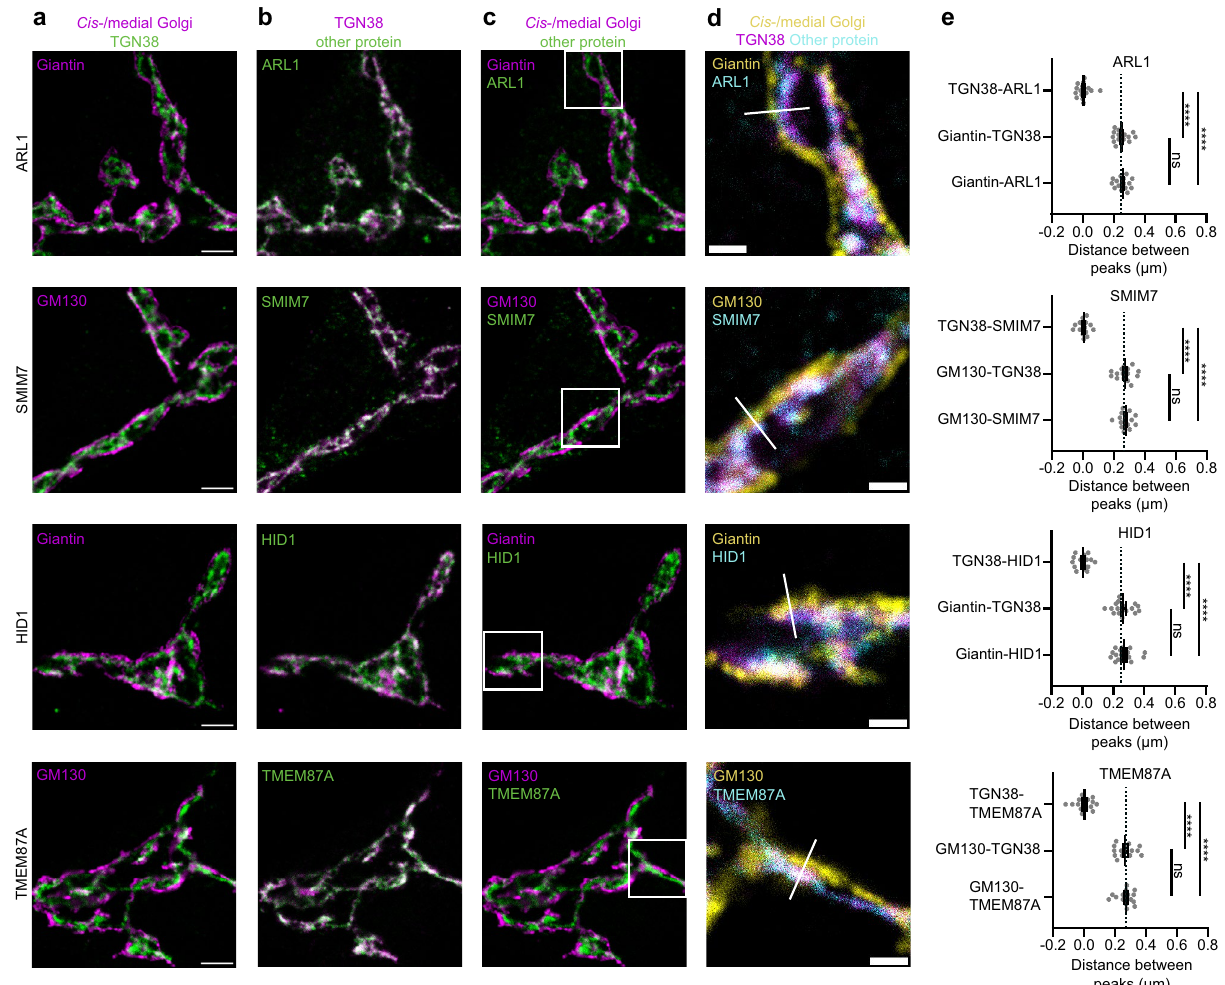
Figure 3. Several Golgi proteins overlap with TGN38. ( a – c ) Representative examples of neurons immunostained for a cis -/medial Golgi marker (GM130 or giantin), TGN38 and a protein of interest (ARL1, SMIM7, HID1 and TMEM87A). Images showing immunostaining of cis -/medial Golgi marker and TGN ( a ), TGN and protein of interest ( b ), cis -/medial Golgi and protein of interest ( c ). ( d ) Zoom from the white square area marked in ( c ), showing all three stained proteins. White line is a representative example of a line drawn for intensity plotting. ( e ) Distance between intensity peaks of TGN38 and protein of interest, cis -/medial Golgi and TGN; and cis -/medial Golgi and protein of interest, measured by line scans. ARL1: (TGN38-ARL1: n = 15; Giantin-TGN38: n = 15; Giantin-ARL1: n = 15). One-way ANOVA with Tukey’s multiple comparisons test: TGN38-ARL1 vs Giantin-TGN38 and TGN38-ARL1 vs Giantin-ARL1: **** p < 0.0001, Giantin-TGN38 vs Giantin-ARL1: non-significant (ns). SMIM7: (TGN38-SMIM7: n = 15; GM130-TGN38: n = 15; GM130- SMIM7: n = 15). One-way ANOVA with Tukey’s multiple comparisons test: TGN38-SMIM7 vs GM130-TGN38 and TGN38-SMIM7 vs GM130-SMIM7: **** p < 0.0001, GM130-TGN38 vs GM130-SMIM7: non-significant (ns). HID1: (TGN38-HID1: n = 16; Giantin-TGN38: n = 16; Giantin-HID1: n = 16). One-way ANOVA with Tukey’s multiple comparisons test: TGN38-HID1 vs Giantin-TGN38 and TGN38-HID1 vs Giantin-HID1: **** p < 0.0001, Giantin-TGN38 vs Giantin-HID1: non-significant (ns). TMEM87A: (TGN38-TMEM87A: n = 15; GM130-TGN38: n = 15; GM130-TMEM87A: n = 15). One-way ANOVA with Tukey’s multiple comparisons test: TGN38-TMEM87A vs GM130-TGN38 and TGN38-TMEM87A vs GM130-TMEM87A: **** p < 0.0001, GM130-TGN38 vs GM130-TMEM87A: non-significant (ns). Dotted lines represent average distance between TGN38 and GM130 or TGN38 and giantin in the entire dataset. Bars show mean ± SEM. Detailed statistics are shown in Supplementary Table 1. Scale bar is 3 µm ( a ) and 1 µm ( d